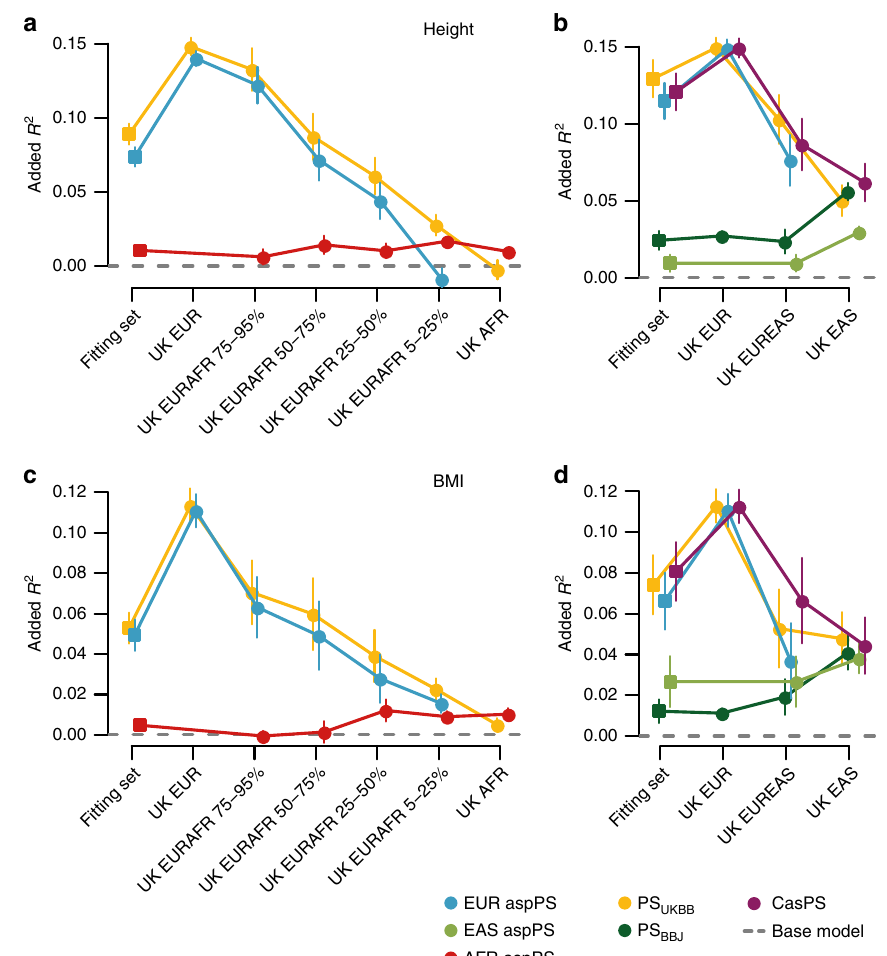
Fig. 5 Predictivity in admixed genomes. Each plot shows the improvement in R 2 when adding a PS to the base, non-genetic model. The line color depicts which PS con fi guration has been used: traditional total PS (PS UKBB or PS BBJ according to the Biobank of origin), partial ancestry speci fi c PSs or combined ancestry speci fi c PS. Dots represent the realized R 2 improvement in each set without resampling, while bars represent standard deviation derived from n = 5000 bootstrap replications. a Added R 2 for height in UKBB samples with admixed African and European ancestry, no casPS was available. b Added R 2 for height in UKBB samples with admixed East Asian and European ancestry. c Added R 2 for BMI in UKBB samples with admixed African and European ancestry; no casPS was available. d Added R 2 for BMI in UKBB samples with admixed East Asian and European ancestry. EUR indicates european descent, EAS east asian descent, AFR african descent; combinations indicate admixed